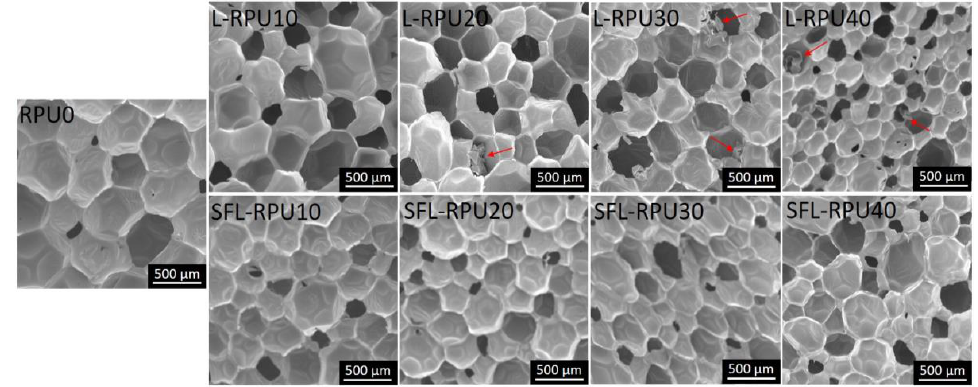
Figure 3. Scanning electron microscopy (SEM) images of L-RPU ( top row ) and SFL-RPU ( bottom row ) foams made with different amounts (0–40%) of lignin.